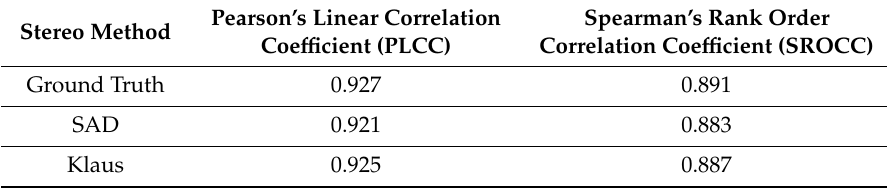
Table 3. The performance of the proposed method using di ff erent stereo